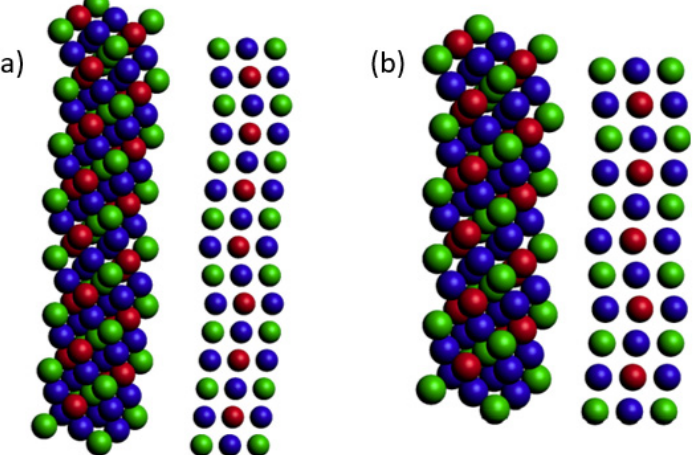
Figure 5. Schema of the L2 1 Heusler crystallographic structure ( left ) indicating with red lines the cell of the L1 0 tetragonal martensite ( right ) for stoichiometric Ni 50 Mn 25 Ti 25 alloy. The Ni 2 − x Co x Mn 1.4 Ti 0.6 quaternary series was discovered by Wei et al. [19], who em ‐